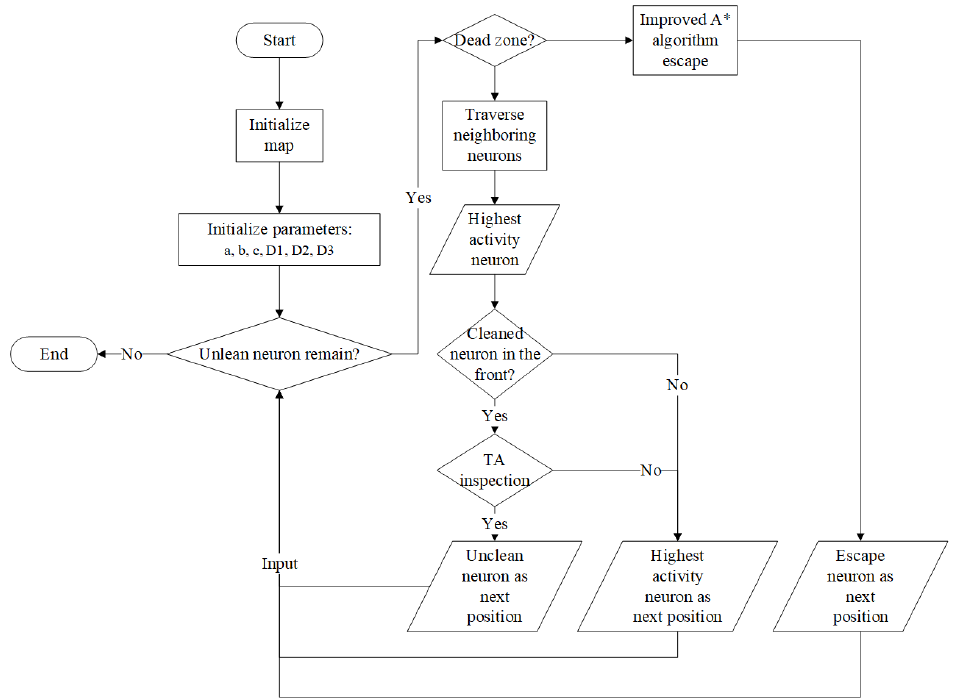
Figure 11. The flow of the CCNN algorithm.